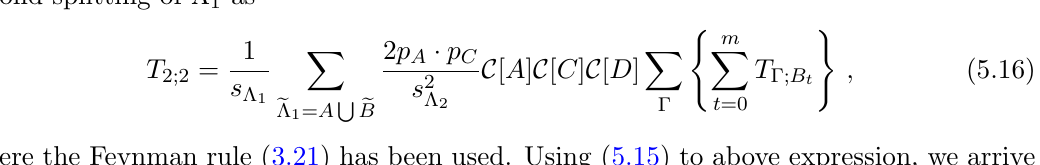
T (cid:0); B t =0 t